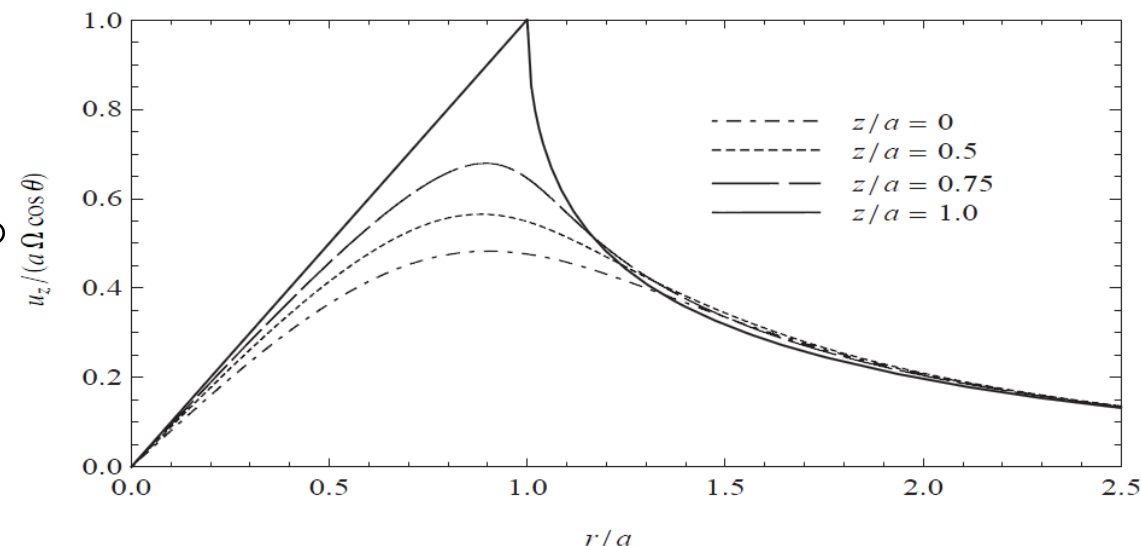
Fig. 5. Normal displacement profile along the radial axis at different depths of a Beryl rock half-space ( s/a=1 ). (a ) z s , (b) z s